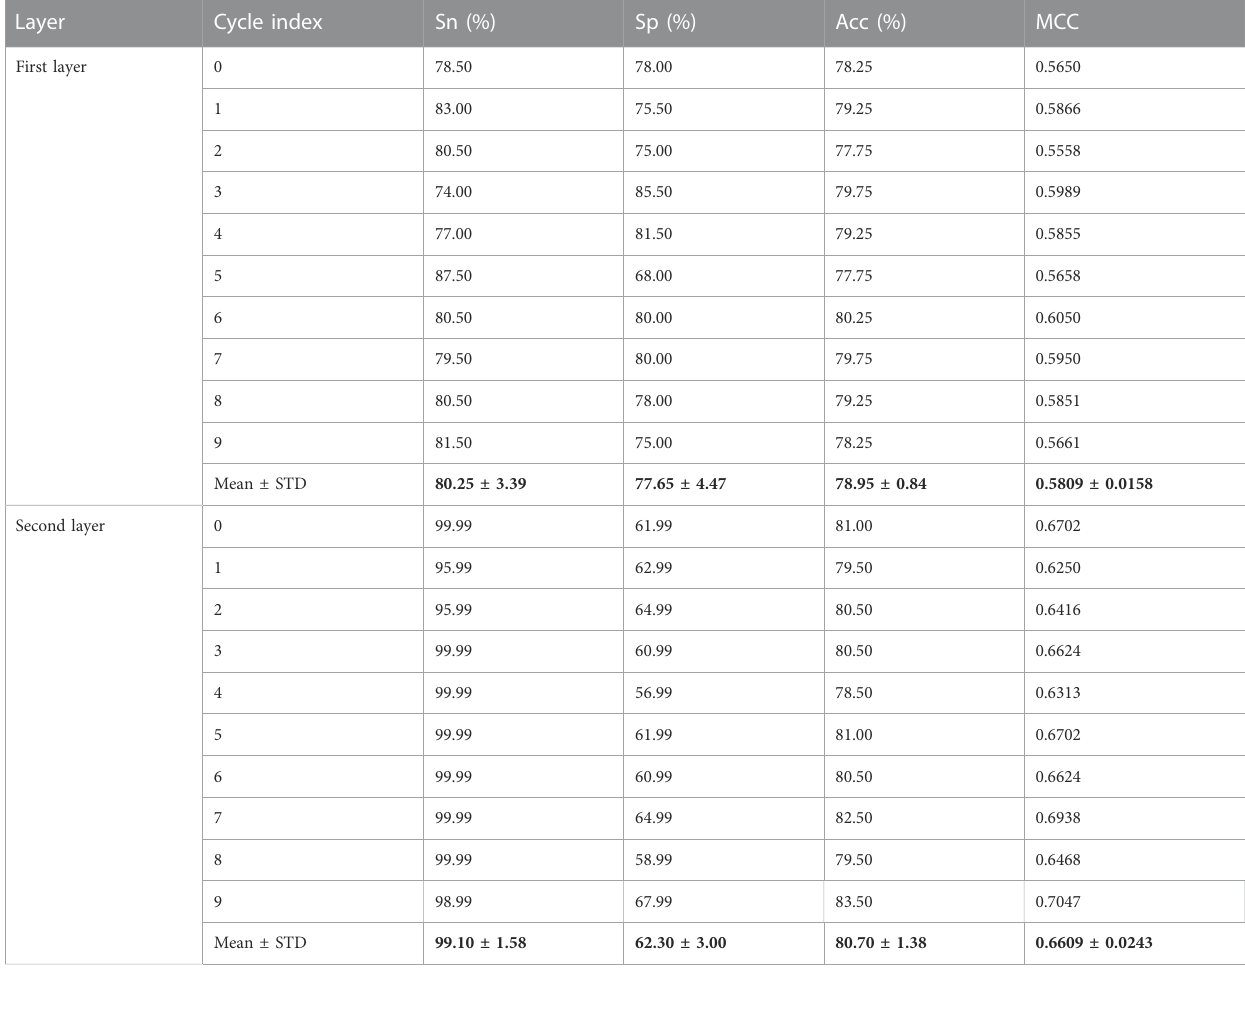
TABLE 5 Performance of iEnhancer-DCSV in 10 trials.